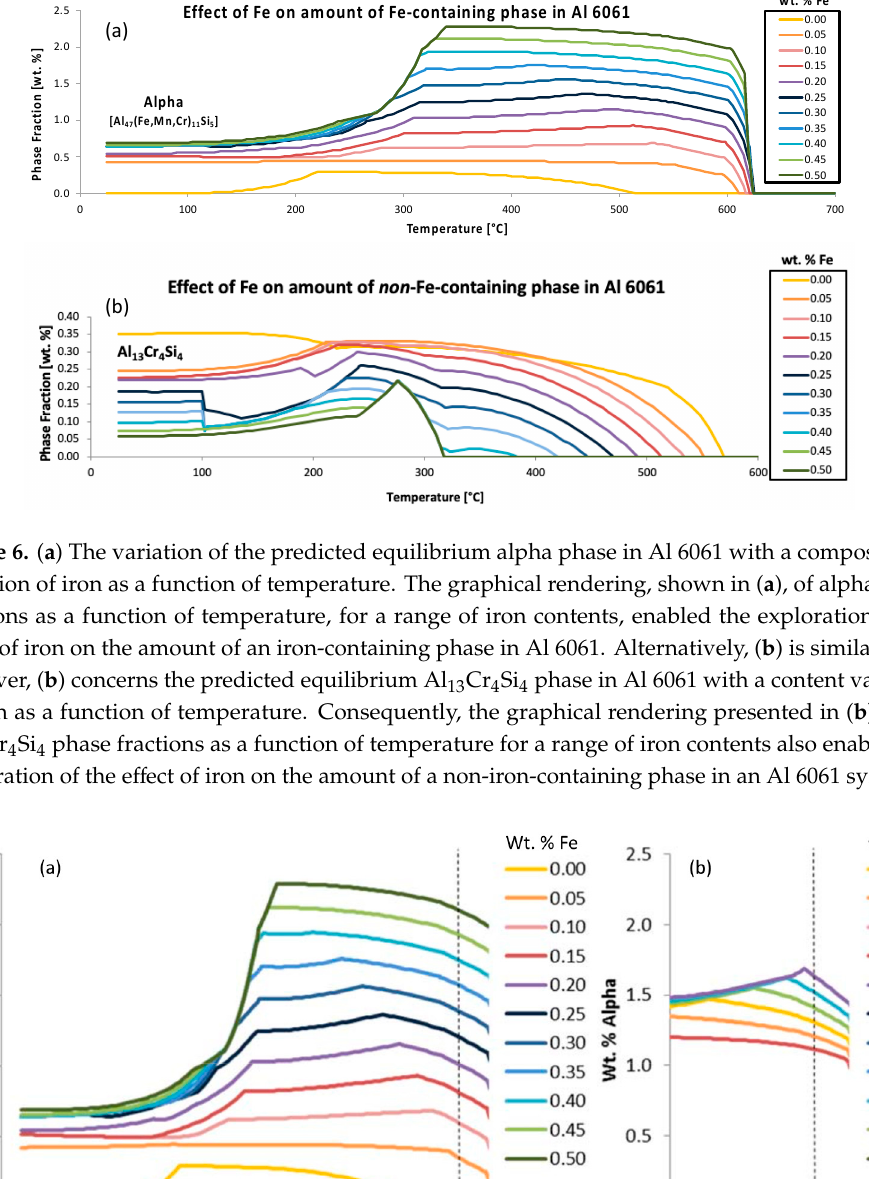
Figure 8. Variation in the prediction of the equilibrium alpha phase in Al 6061 with a content variation of chromium according to the legend provided. The vertically dashed line superimposed upon the wt.% alpha versus temperature curves was included to signify a temperature of 560 °C that was associated with the embedded demonstration of 𝜓 computation.